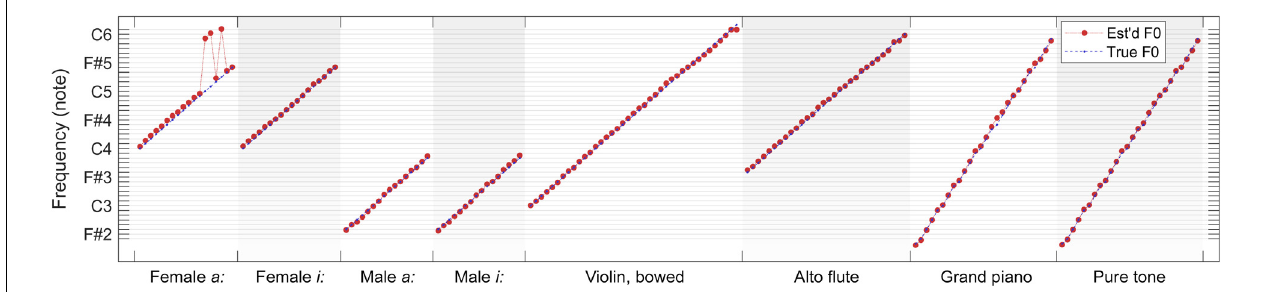
FIGURE 12 | Comparison of true fundamental frequencies versus combined F0 estimates (weighted median over 100 iterations) for each tested note within each sound